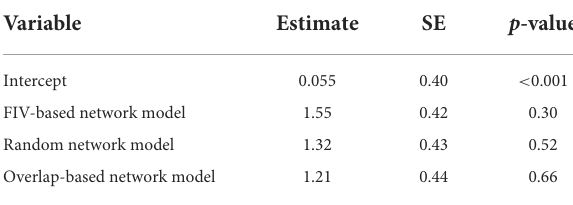
TABLE 2 Fixed effects results from model-type performance